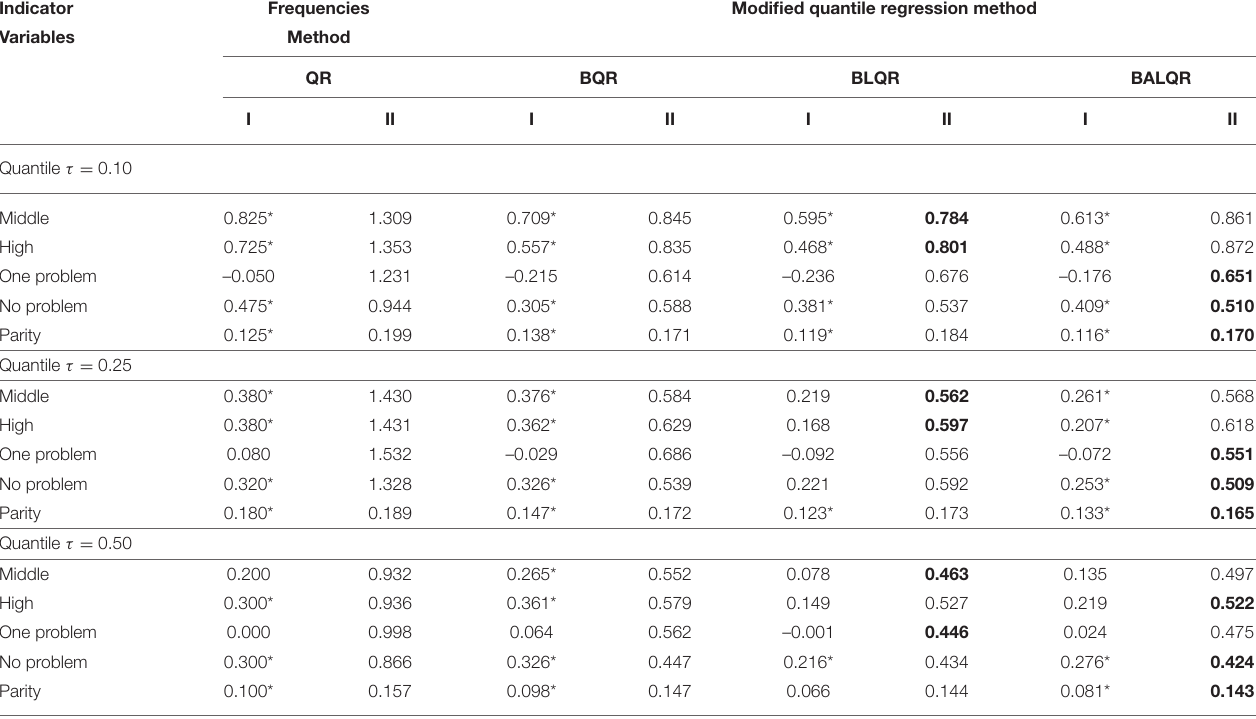
0.10,0.25, and 0.50. =